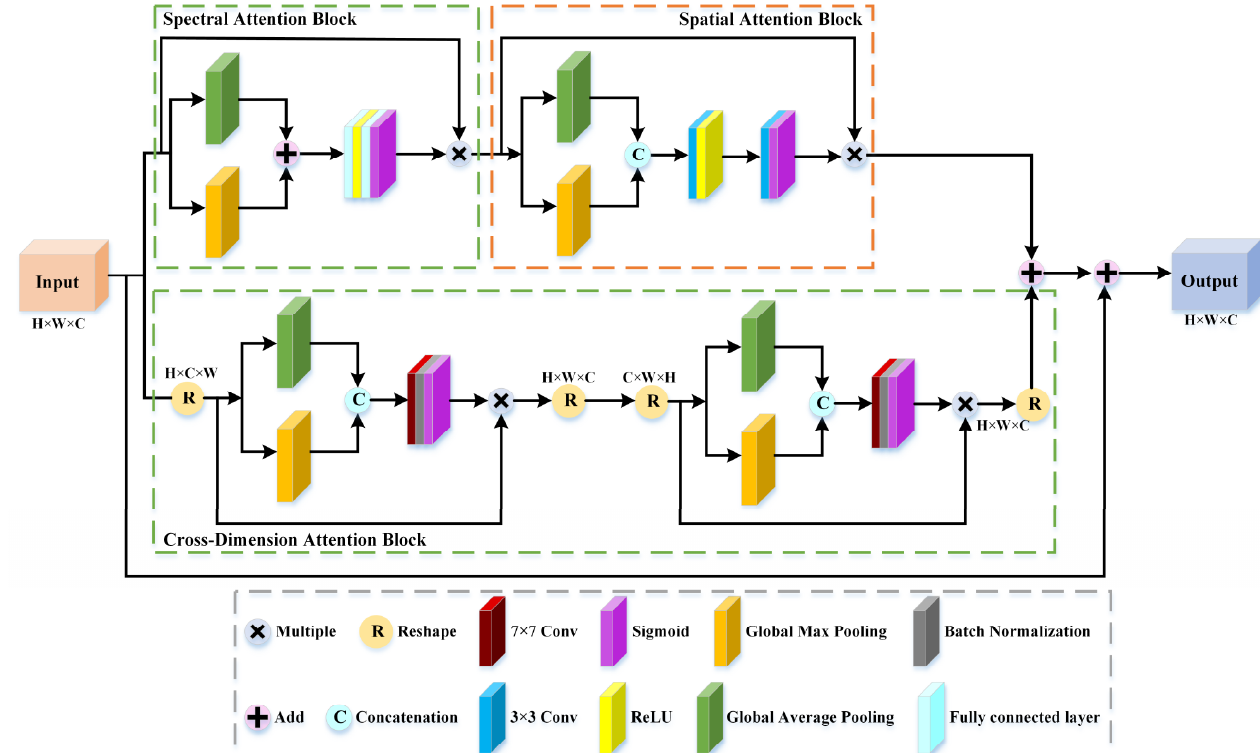
Figure 2. The diagram of interaction attention module (IAM).